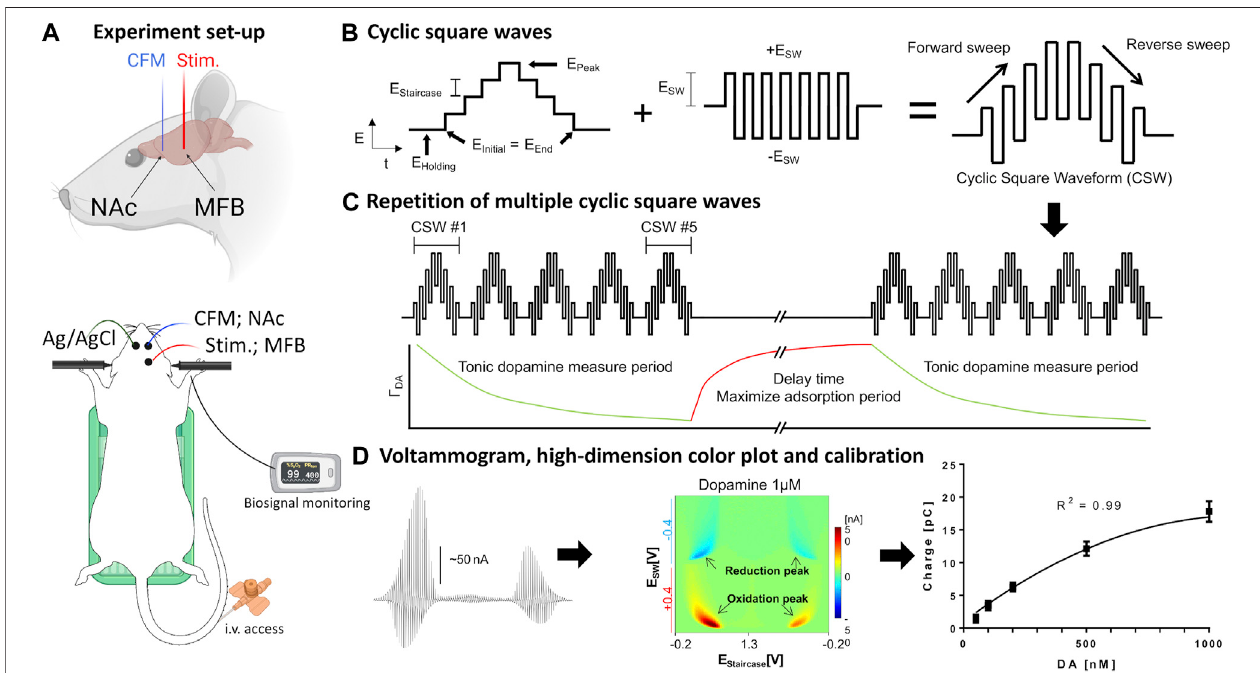
FIGURE 1 | Set-up of in vivo voltammetry experiment. (A) Rat surgery set-up. Recording and stimulating electrodes were inserted unilaterally into the core of the nucleus accumbensand medialforebrainbundle, respectively.Thecounter-referenceAg/AgClelectrodewas insertedcontralaterally intocorticaltissue. Therat isplacedinastereotactic framewithtailveinaccess,heatingpad,andpulseoximetrymonitoring. (B,C) Schematicdesignofwaveform-CSWVappliedtotheCFManditsresponse. (D) Left-to-right:Raw voltammogram after removal of background currents, high-dimensional pseudo-color plot, M-CSWV signal calibration with tonic dopamine experiment ( n (cid:1) 4 electrodes). Figuresadoptedfrom(Ohetal.,2018)withpermission. Ag/AgCl ,silverchloridereferenceelectrode; CFM ,carbon- fi berelectrode; CSW ,cyclicsquarewave; MFB ,medialforebrain bundle; NAc , nucleus accumbens; stim. , bipolar stimulating electrode. Parts of the Figure were created with Biorender.com.